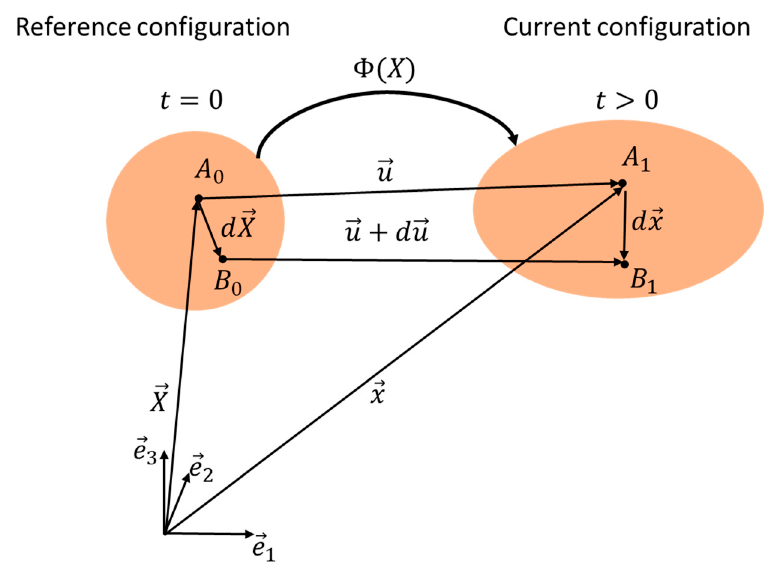
Figure 1. Reference and current configuration of the material points A 0 and B 0 in the same coordinate system e i as well as the Equation of motion Φ ( X , t )